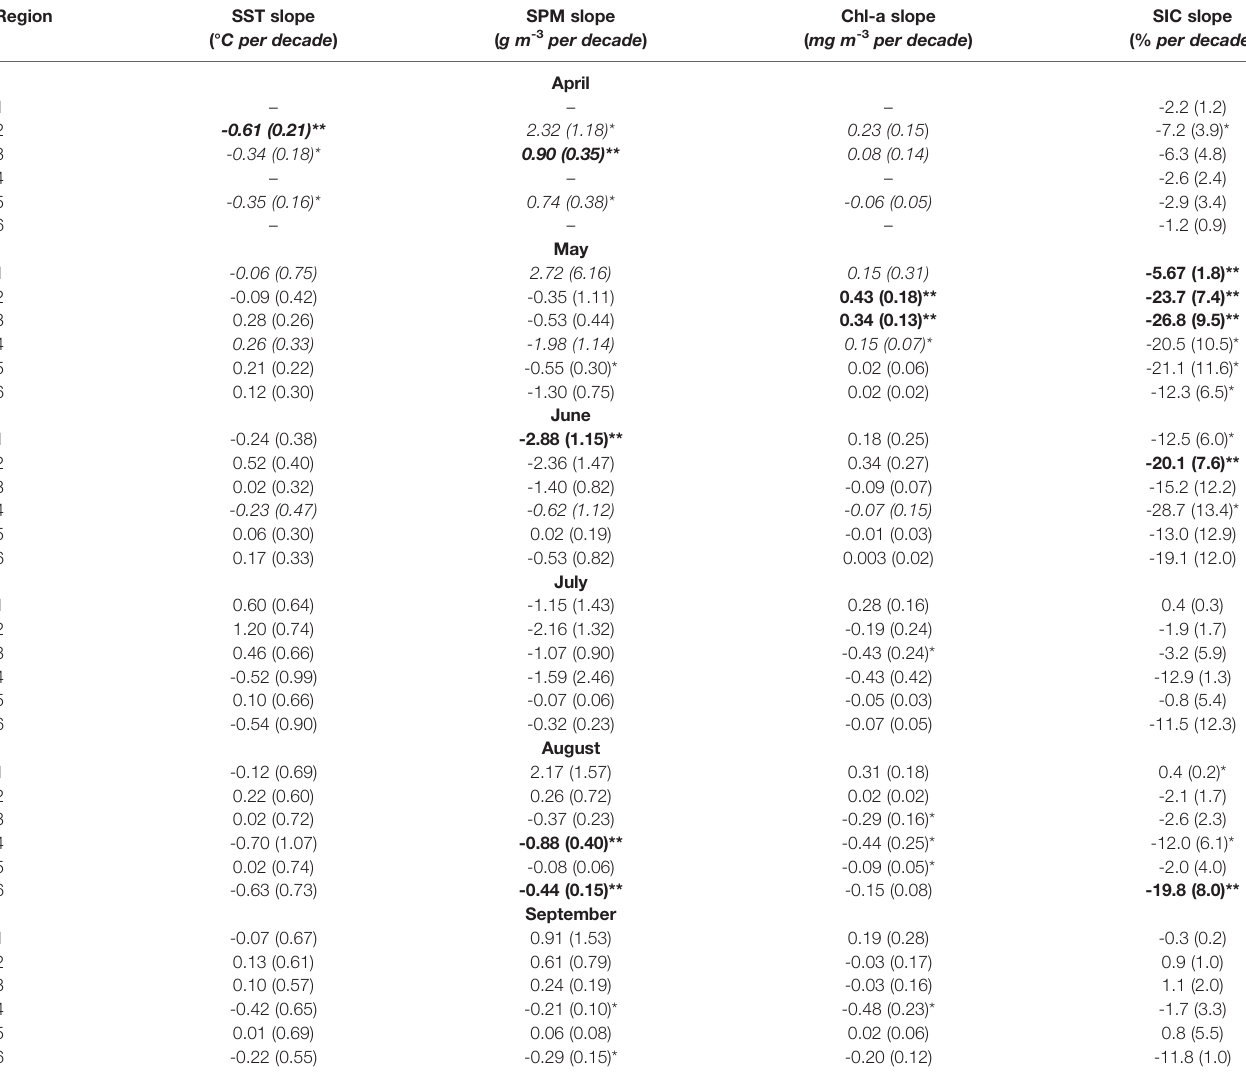
TABLE 3 | Monthly mean trends of SST, SPM, Chl-a and SIC for the six regions over 2003 – 2019, with slope expressed per decade. Region SST